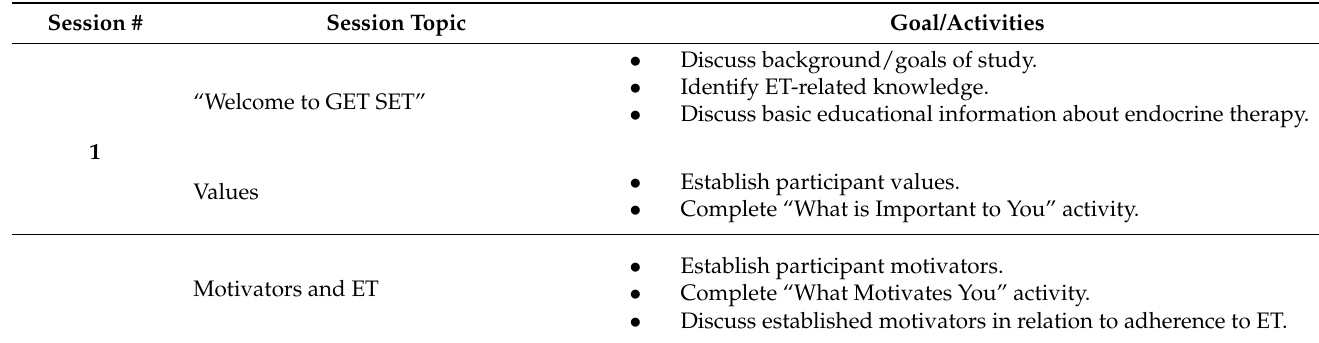
Figure A1. Study flow and timeline of activities. Table A1. Motivational interviewing counseling session content and activities.